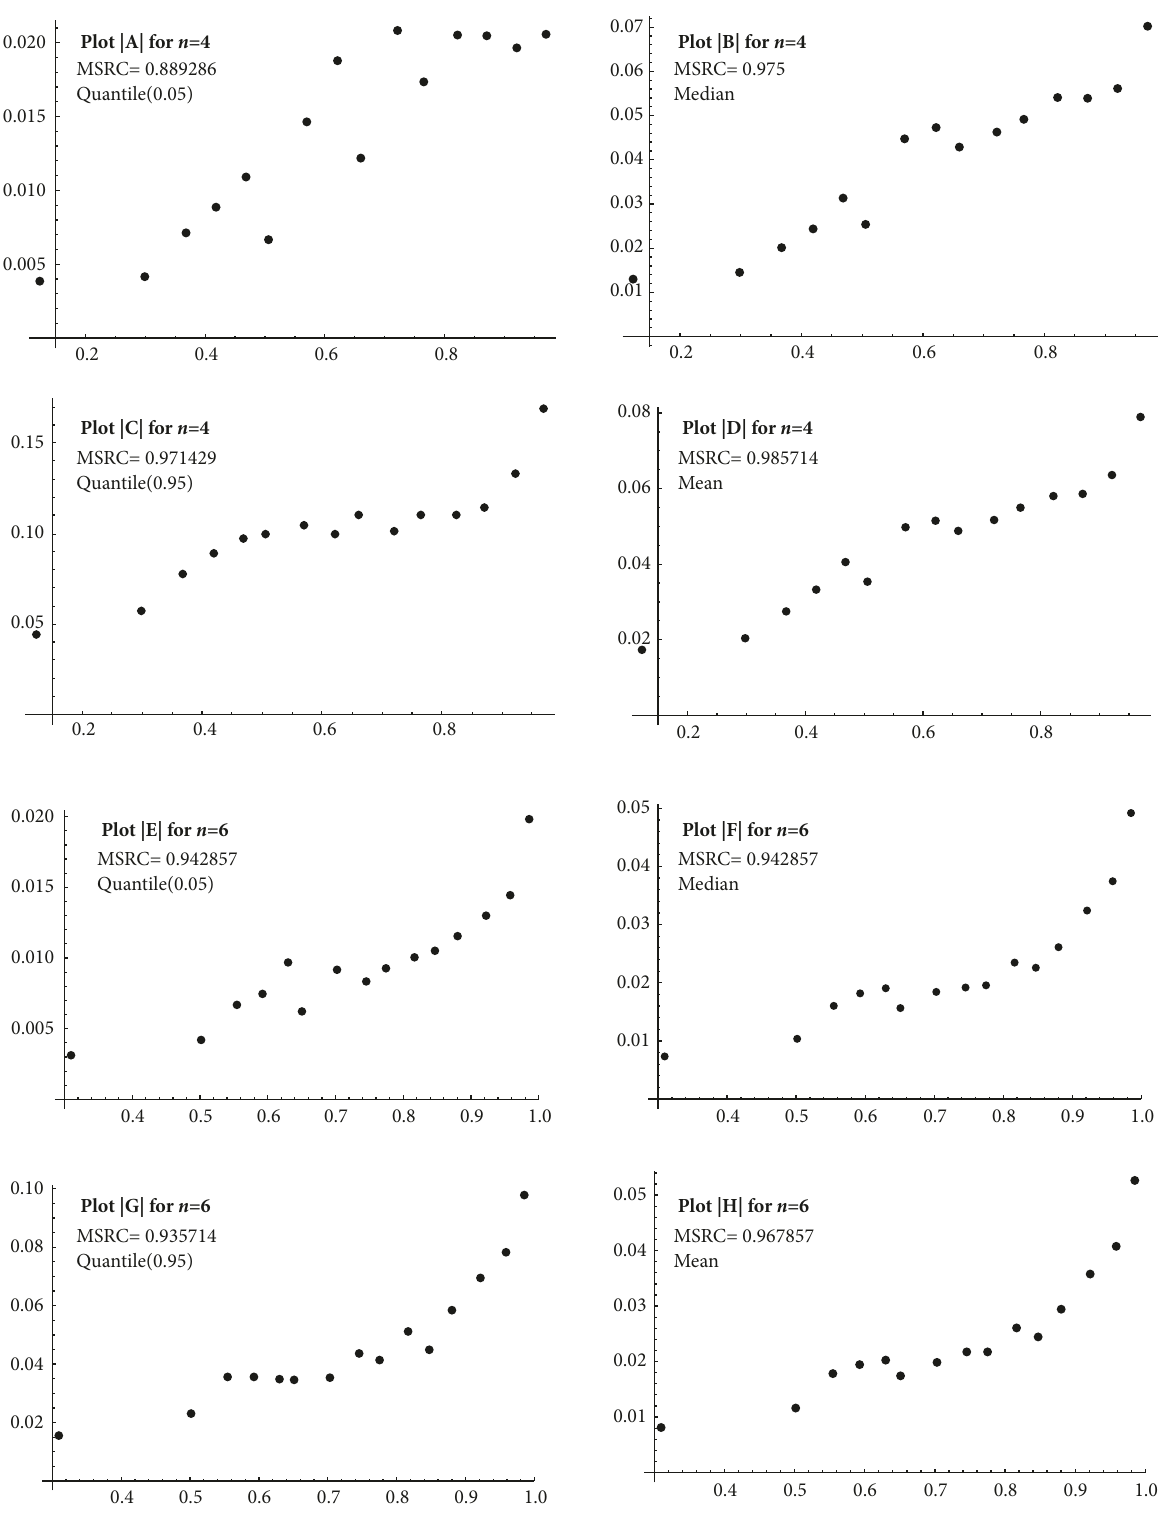
Figure 1: Performance of K ( A ) as PCM-CM . The plots present the relation between mean values of K ( A ) within a given interval (VRCM n ) and values of MAEs and quantiles of a given order for MAEs distribution concerning estimated and true PV for the case. The results are generated with application of LLSM as the PP and geometric scale , i.e., 𝑓(𝑛) = 𝑐 𝑛/2 for 𝑛 ∈ {−8,. .. ,8} ∧ 𝑛 ∈ 𝐼 as the preference scale with its most popular parameter c= 2. Plots are based on 10,000 random reciprocal PCMs for n =4 and n= 6. MSRC denotes Mean Spearman Rank Correlation Coefficient between analyzed variables and describes their relation’s